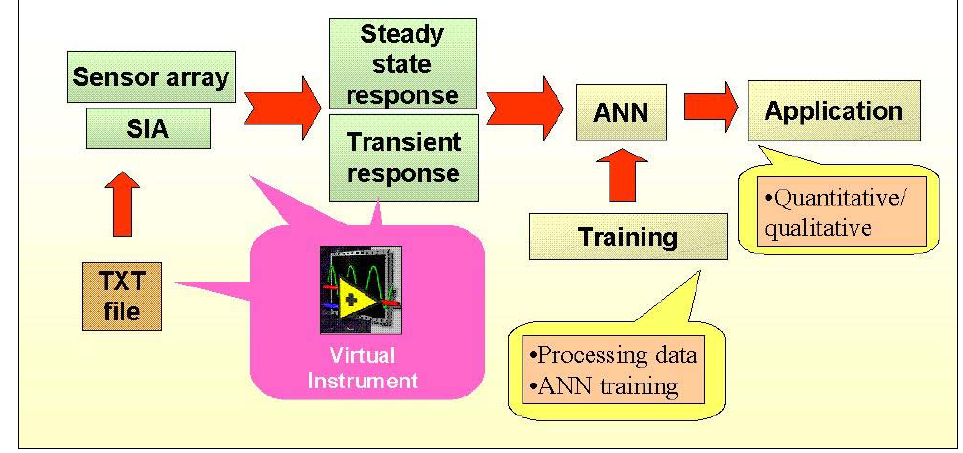
Figure 1. Design strategy for the automated SIA